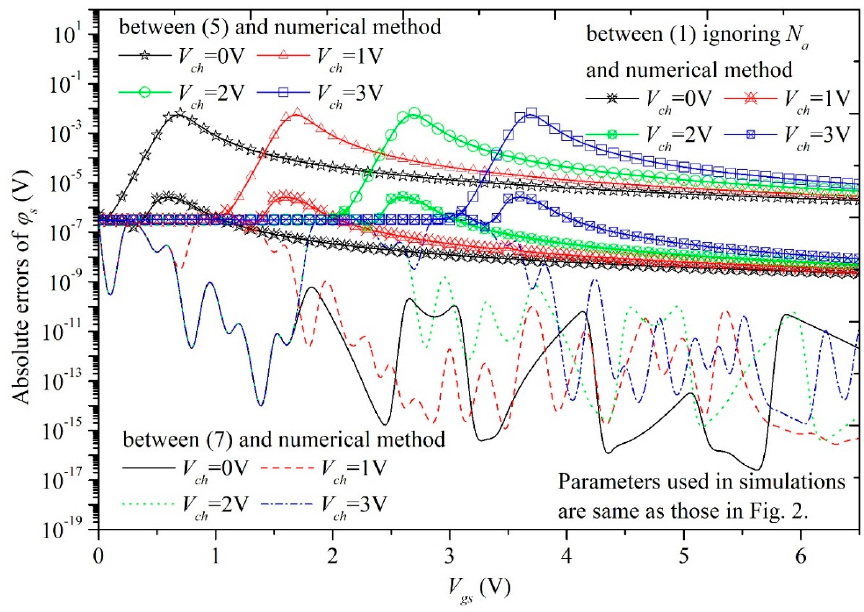
Figure 3. Absolute errors of ϕ s between solution and numerical method vs . V gs .